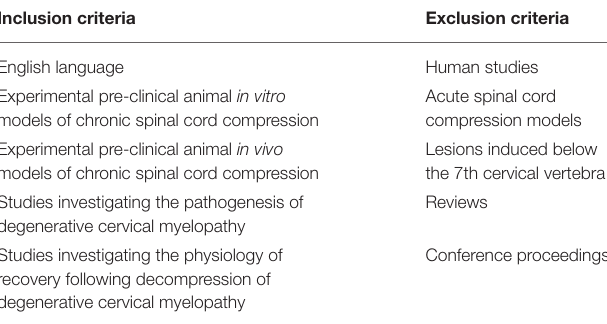
TABLE 1 | Inclusion and exclusion